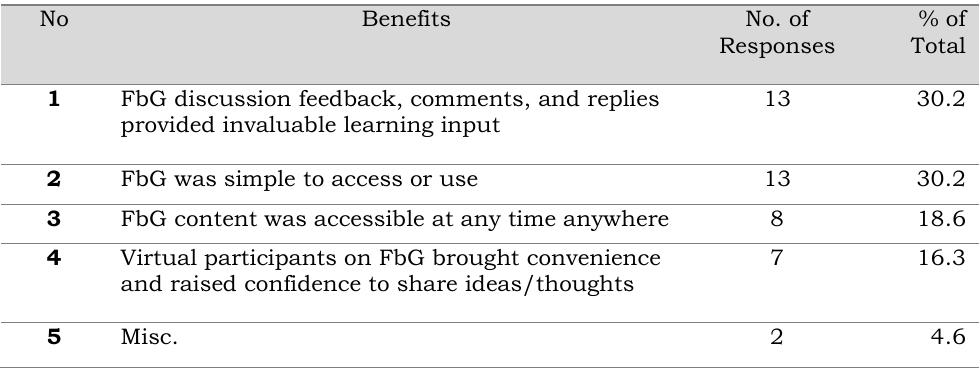
Table 3. Benefits of FbG Usage According to